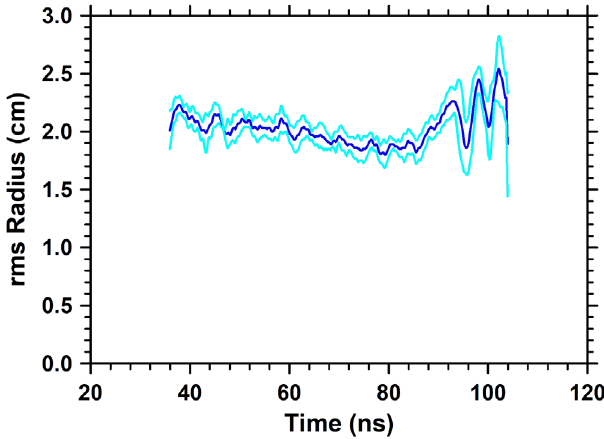
FIG. 14. Average of beam rms radii calculated for ten shots with DT-1 set for a peak field of 0.80 kG (blue curve). These included shots with the DML bias field set to 50, 100, and 200 G. Also shown in cyan is the average (cid:3) 1 standard deviation as an indication of the uncertainty of the